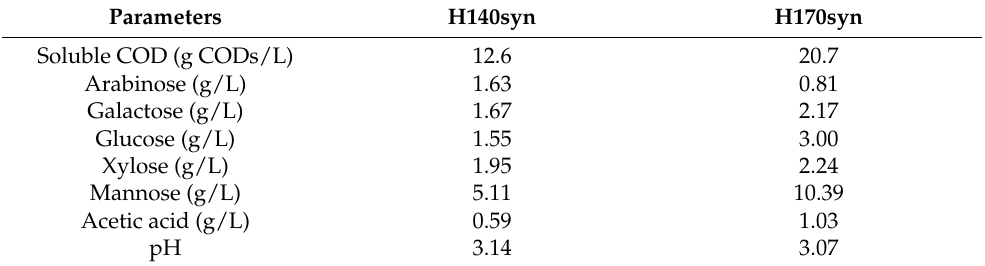
Table 1. Content of synthetic hydrolysate. (chemical oxygen demand) COD, chemical oxygen demand.